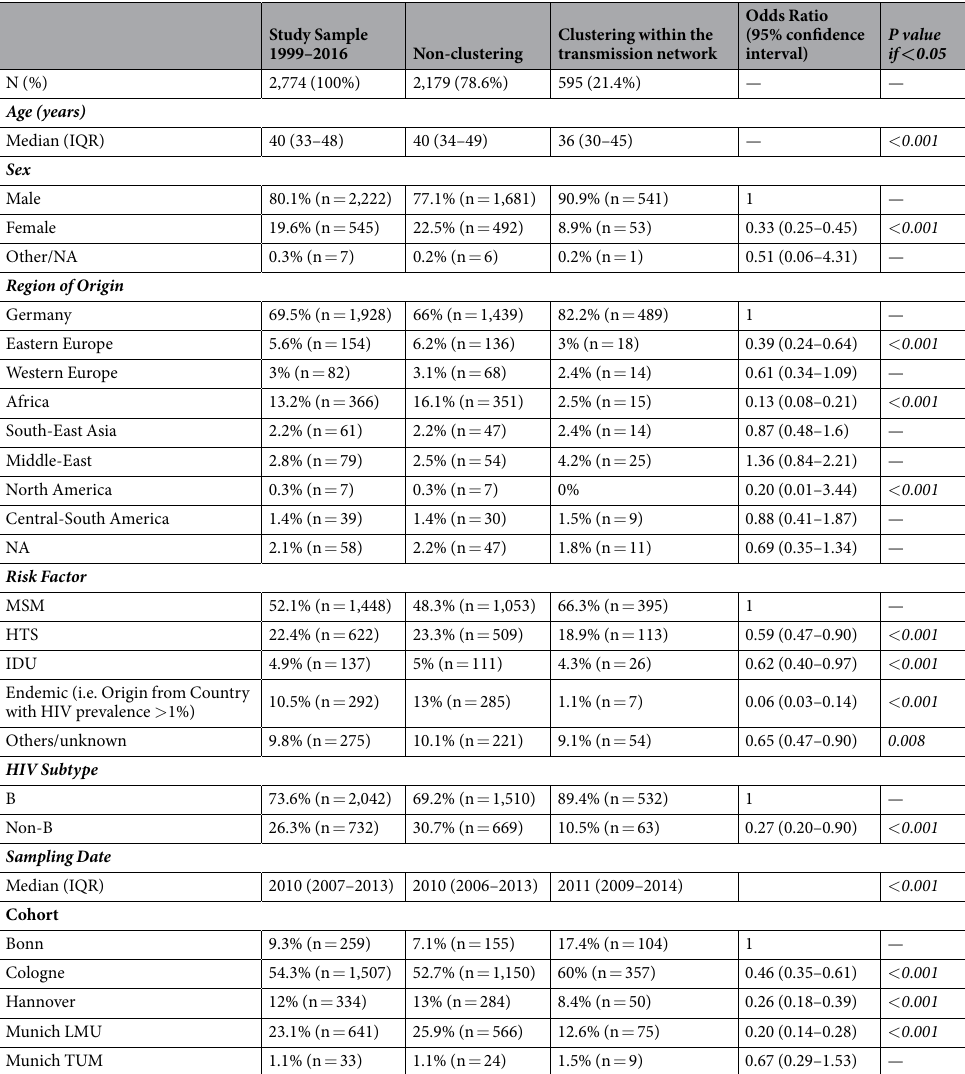
Table 1. Population Characteristics. Baseline Demographic, Risk and Viral Characteristics in Clustering versus non-Clustering participants. Abbreviations: HTS, heterosexual sex; IDU, injection drug use; MSM, men who have sex with men; NA, not